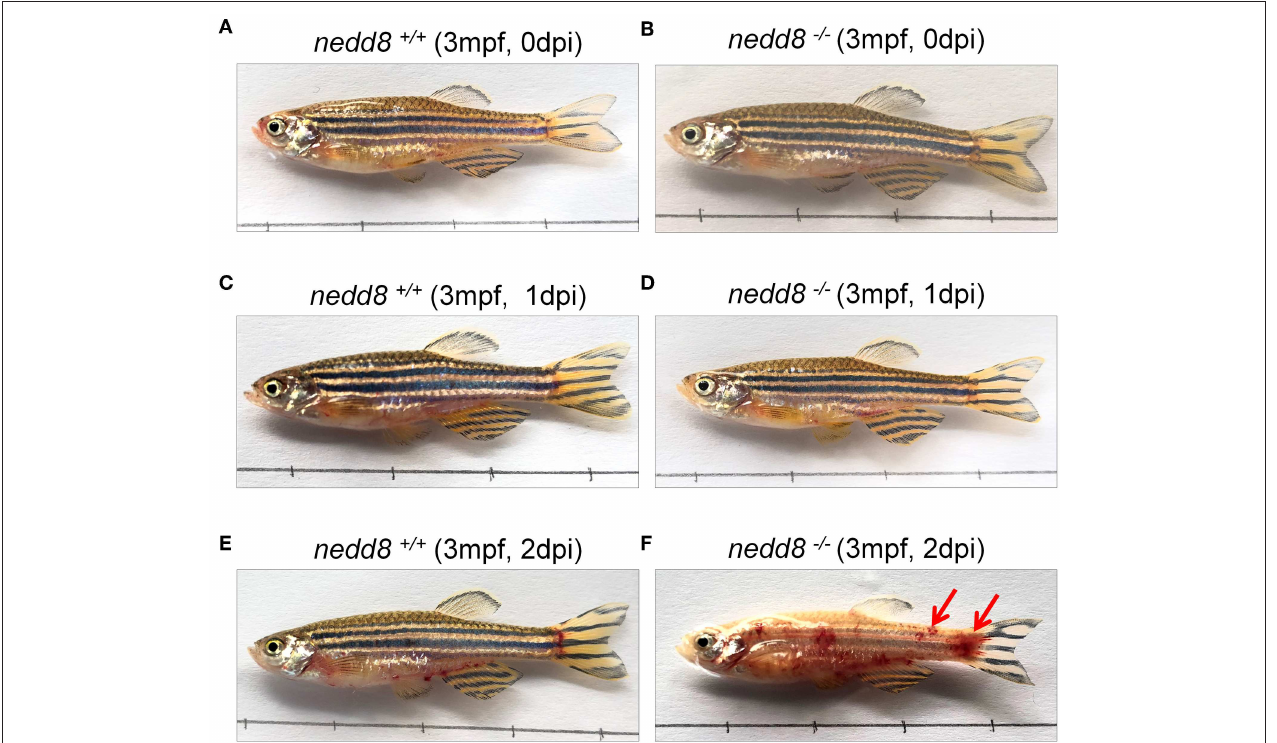
FIGURE 8 | nedd8 -null adult zebrafish are more sensitive to SVCV infection than WT zebrafish. (A,B) nedd8 -null zebrafish (3 mpf; 0.38 ± 0.02g) and the WT (3 mpf; 0.38 ± 0.02g) were each i.p. injected with 10 µ L SVCV ( ∼ 2 × 10 8 TCID 50 /ml) at 0 day. (C,D) At 1 day post-injection (dpi), there were no obvious differences between the WT ( nedd8 + / + ) and nedd8 -null zebrafish ( nedd8 − / − ). (E,F) At 2 dpi, the WT zebrafish appeared normal, but the nedd8 -null zebrafish had more swelling and hemorrhagic symptoms in the abdomen (indicated by red